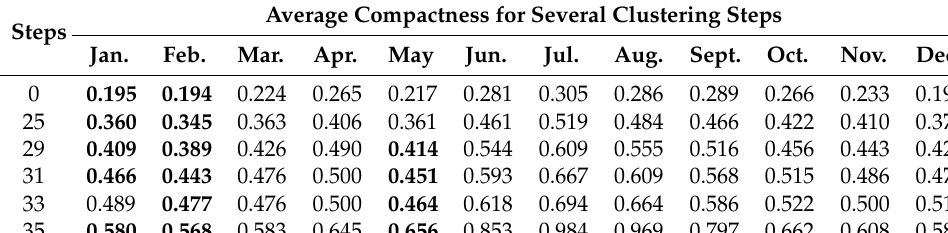
Table 7. Average compactness of each feature in selected clustering steps.